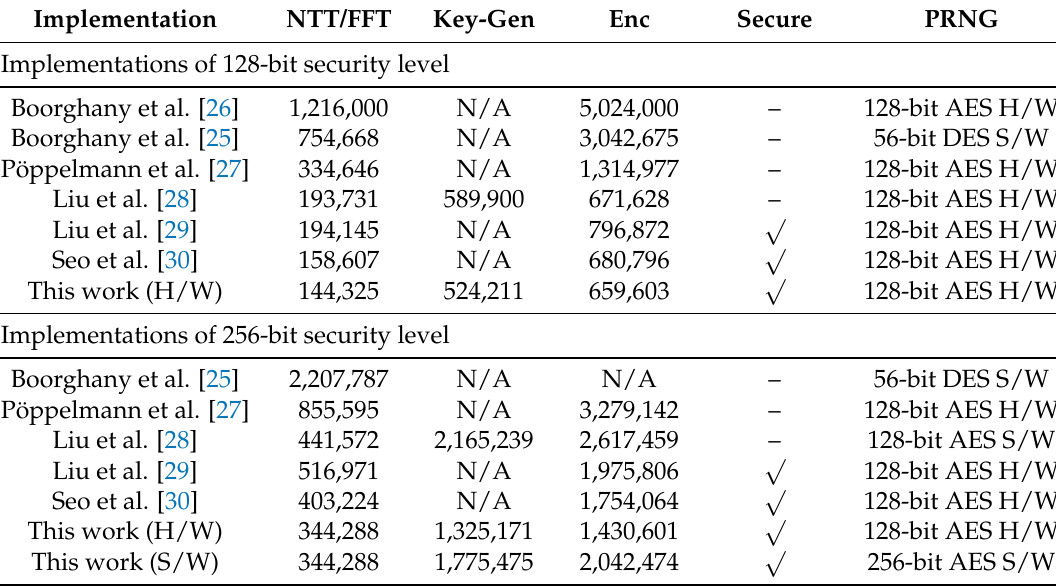
Table 3. Performance comparison of software implementation of 128-bit and 256-bit security